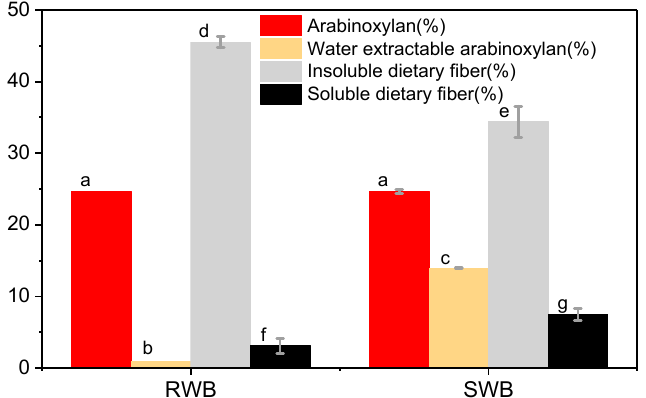
Figure 2. Chemical composition of raw wheat bran (RWB) and steam-exploded wheat bran (SWB); means that are significantly different ( p < 0.05) are indicated by different letters.